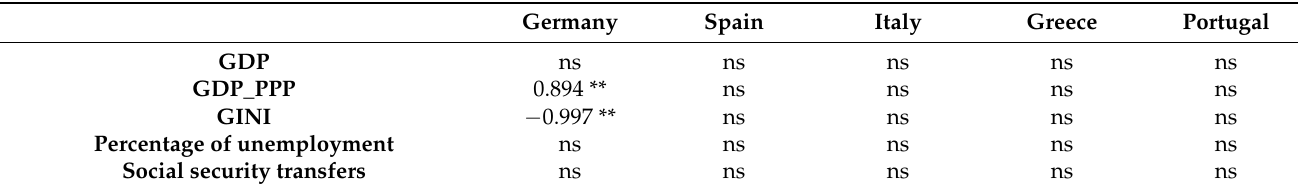
Table 2. Correlations between economic trends and national identity (percentage of citizens very attached to country) in Germany, Spain, Italy, Greece, and Portugal in 2000–2012. Authors’ own elaboration from several sources (see Appendix A). p values: ** ≤